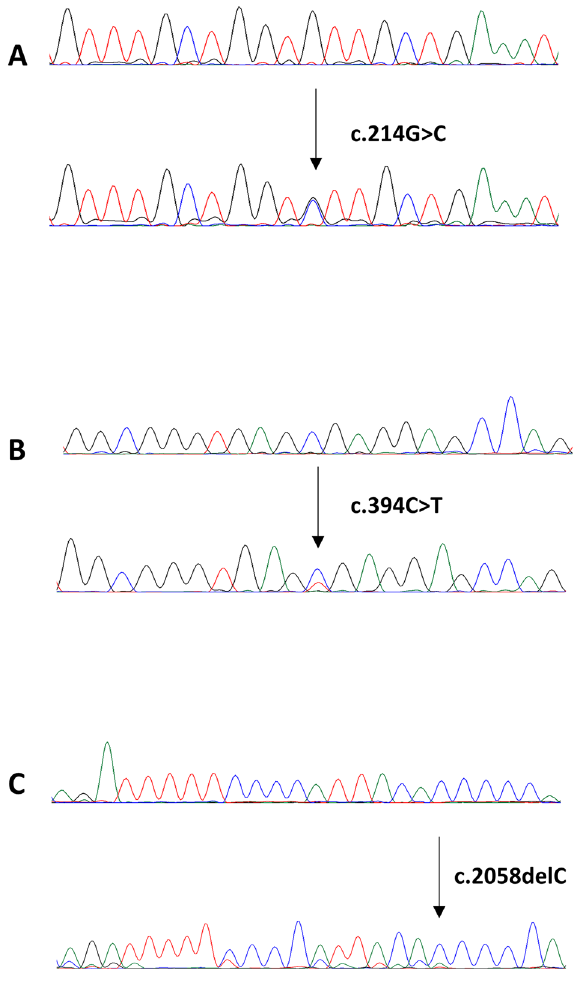
Figure 1. Electropherogram of three RNF43 representative mutations identified CRC cases. Upper traces represent normal sequences while lower traces show mutated sequences. ( A ) Missense mutation, ( B ) stopgain mutation, ( C ) frameshift